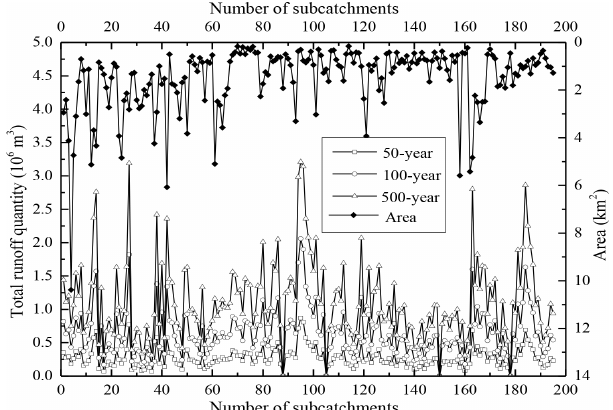
Figure 4. Runoff volume of each subcatchment in the correspond- ing area under different rainfall